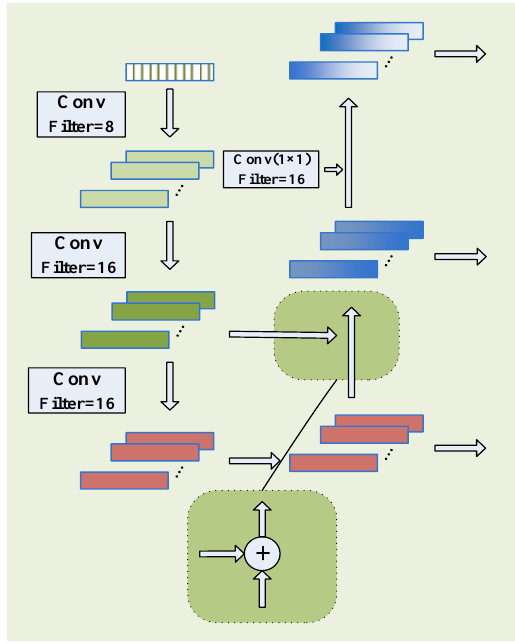
Figure 2. Structure of the FPN feature extraction block.